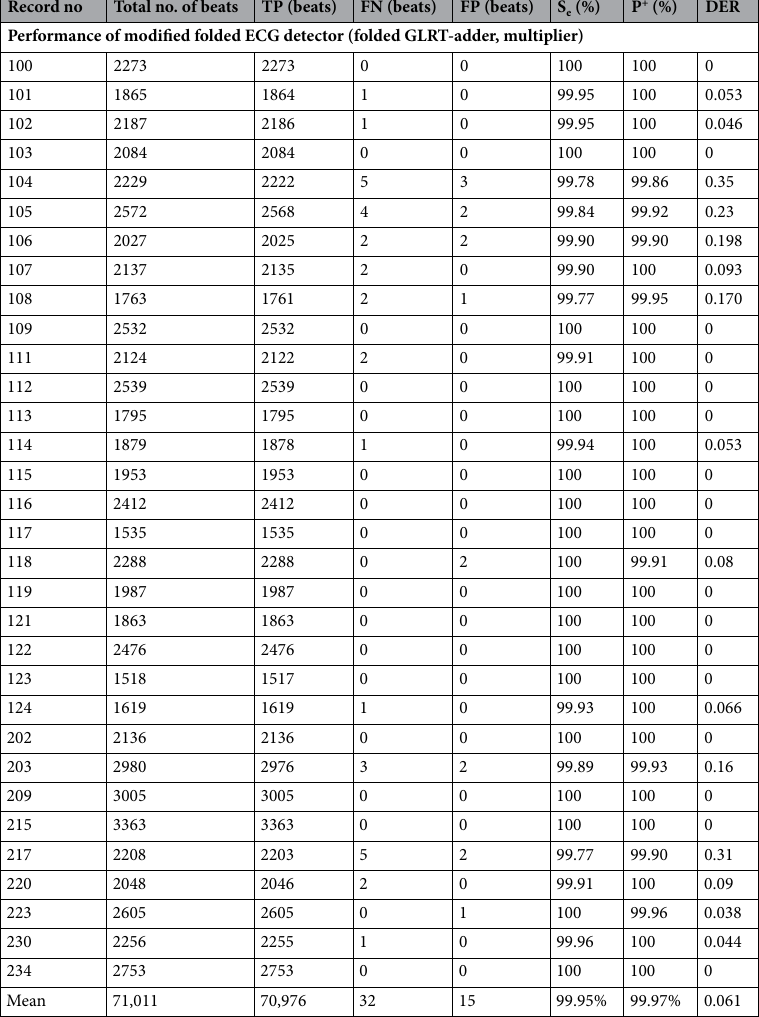
Table 4. Performance of modified folded ECG detector with 1-h database.